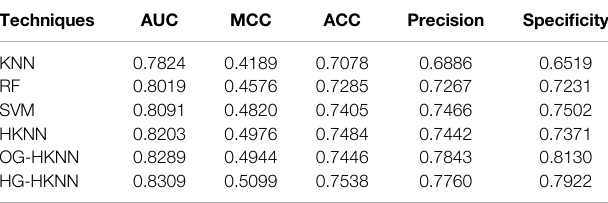
TABLE 4 | Comparison of classi fi cation metrics among different